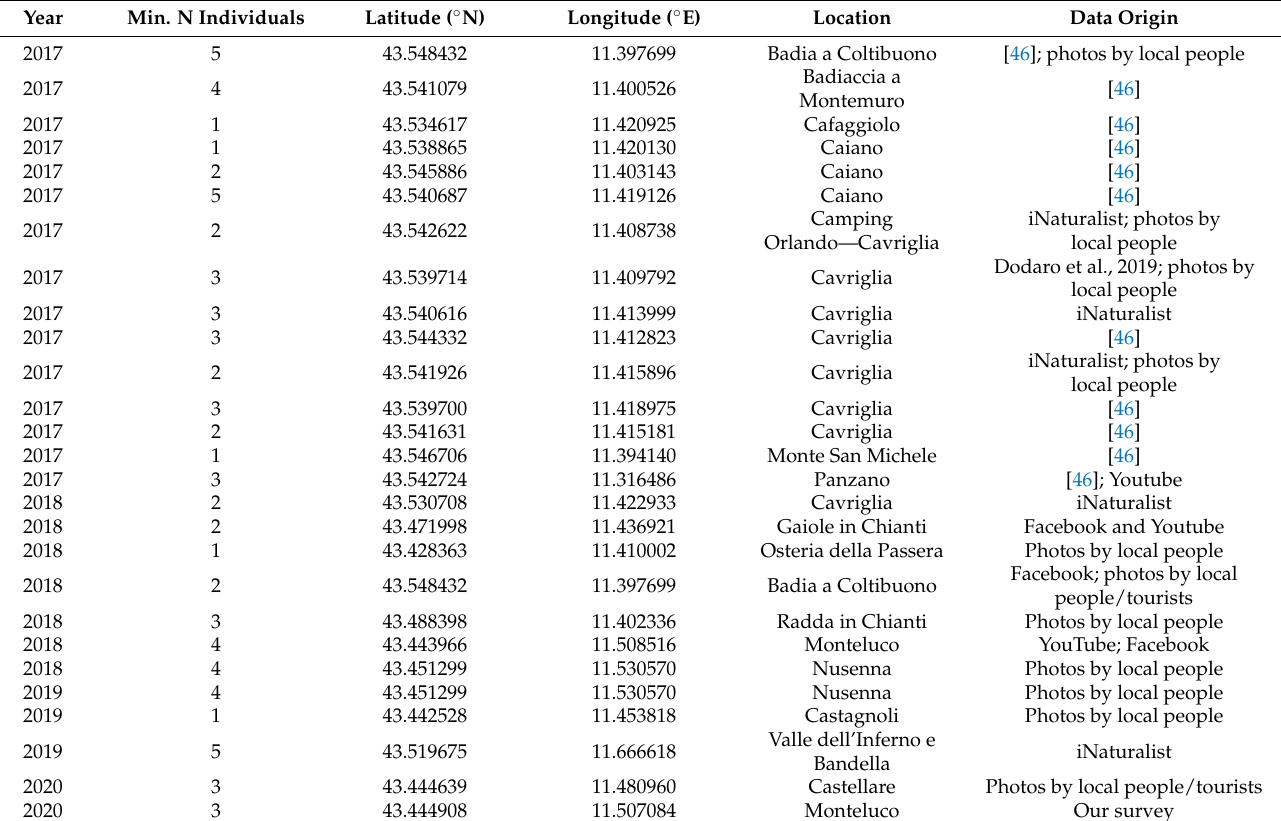
Table 1. Records of encounters of free-ranging llamas (minimum number of individuals) in Monti del Chianti and Valdarno since 2017 (synthesis of our survey and previous